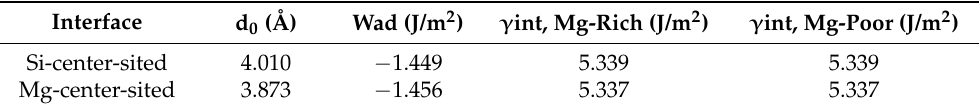
Table 3. The interfacial spacing of complete relaxation of Mg 2 Si (011)/Gr (0001) interfaces and the corresponding work of adhesion and interfacial